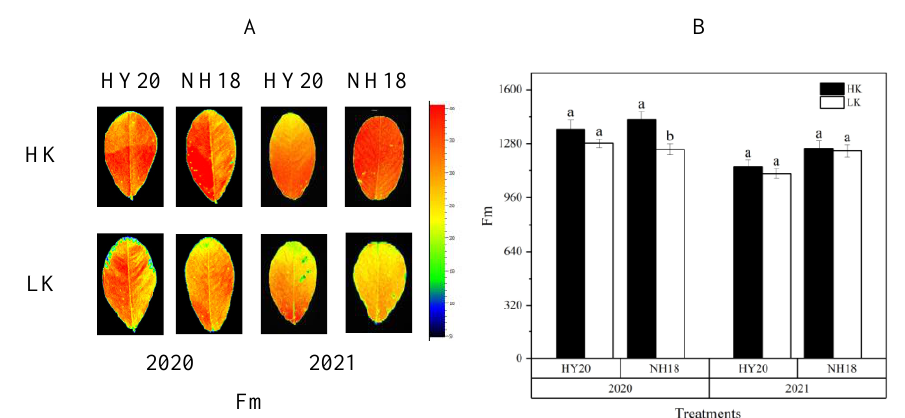
Figure 6. Chlorophyll fluorescence imaging under low K stress. Chlorophyll fluorescence imaging under low K stress-Fm ( A ); Effect of low K stress on fluorescence parameter Fm ( B ). HK: high K treatment; LK: low K treatment. For the bar chart, a,b indicates a significant difference between different treatments for the same variety ( p < 0.05).